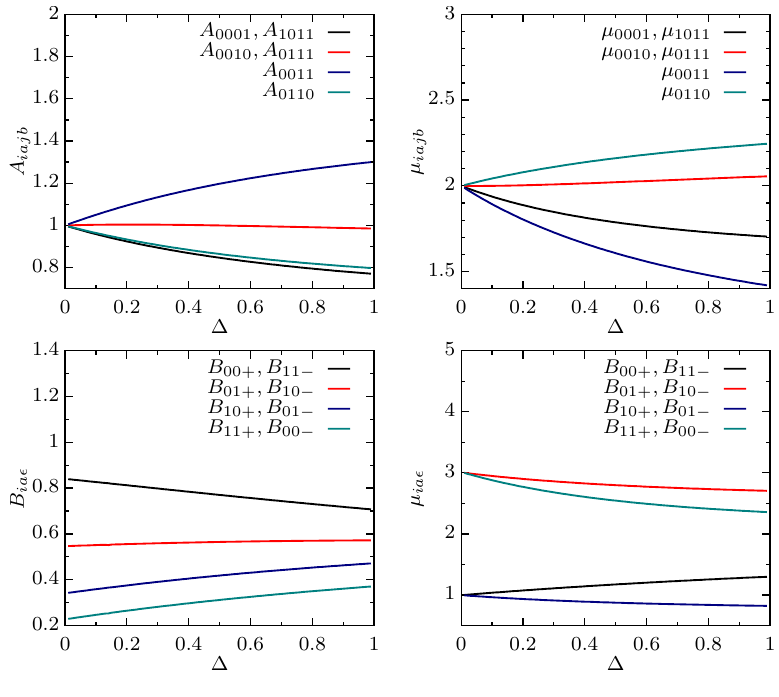
Figure 6: Bogoliubov parameters as a function of anisotropy for the static real space 〈 S z ( x ) S z ( 0 ) 〉 correlations of the multi-component Tomonaga- Luttinger model. The figure shows a comparison between the expansion in small anisotropy (dashed lines) and the parameters computed from inte- grability (solid lines) for a state with a double Fermi sea at N = 200, M = 50 and momentum shift s = 12. Figure 7: Longitudinal static real space correlation 〈 S z ( x ) S z ( 0 ) 〉 , at N = 200, M = 50 for several val- ues of the anisotropy, for a state with momentum split in the Fermi sea by s = 12. The figure com- pares the ABACUS results (points) to the multi-component Tomonaga- Luttinger model (lines). The agree- ment holds not only at large distances, but also down to very short